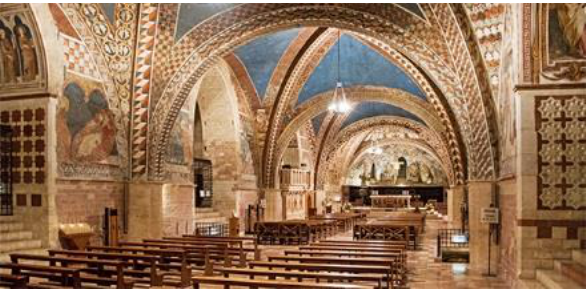
Figure 4. View of the tomb of Saint Francis